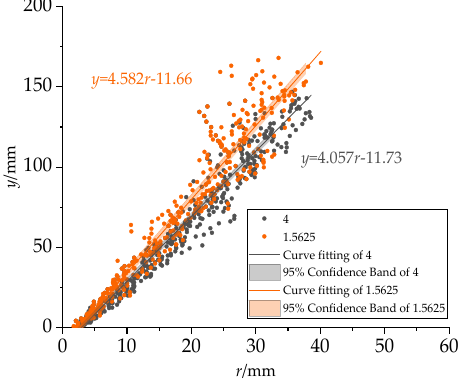
Figure 11. Jet boundary position and linear fitting.